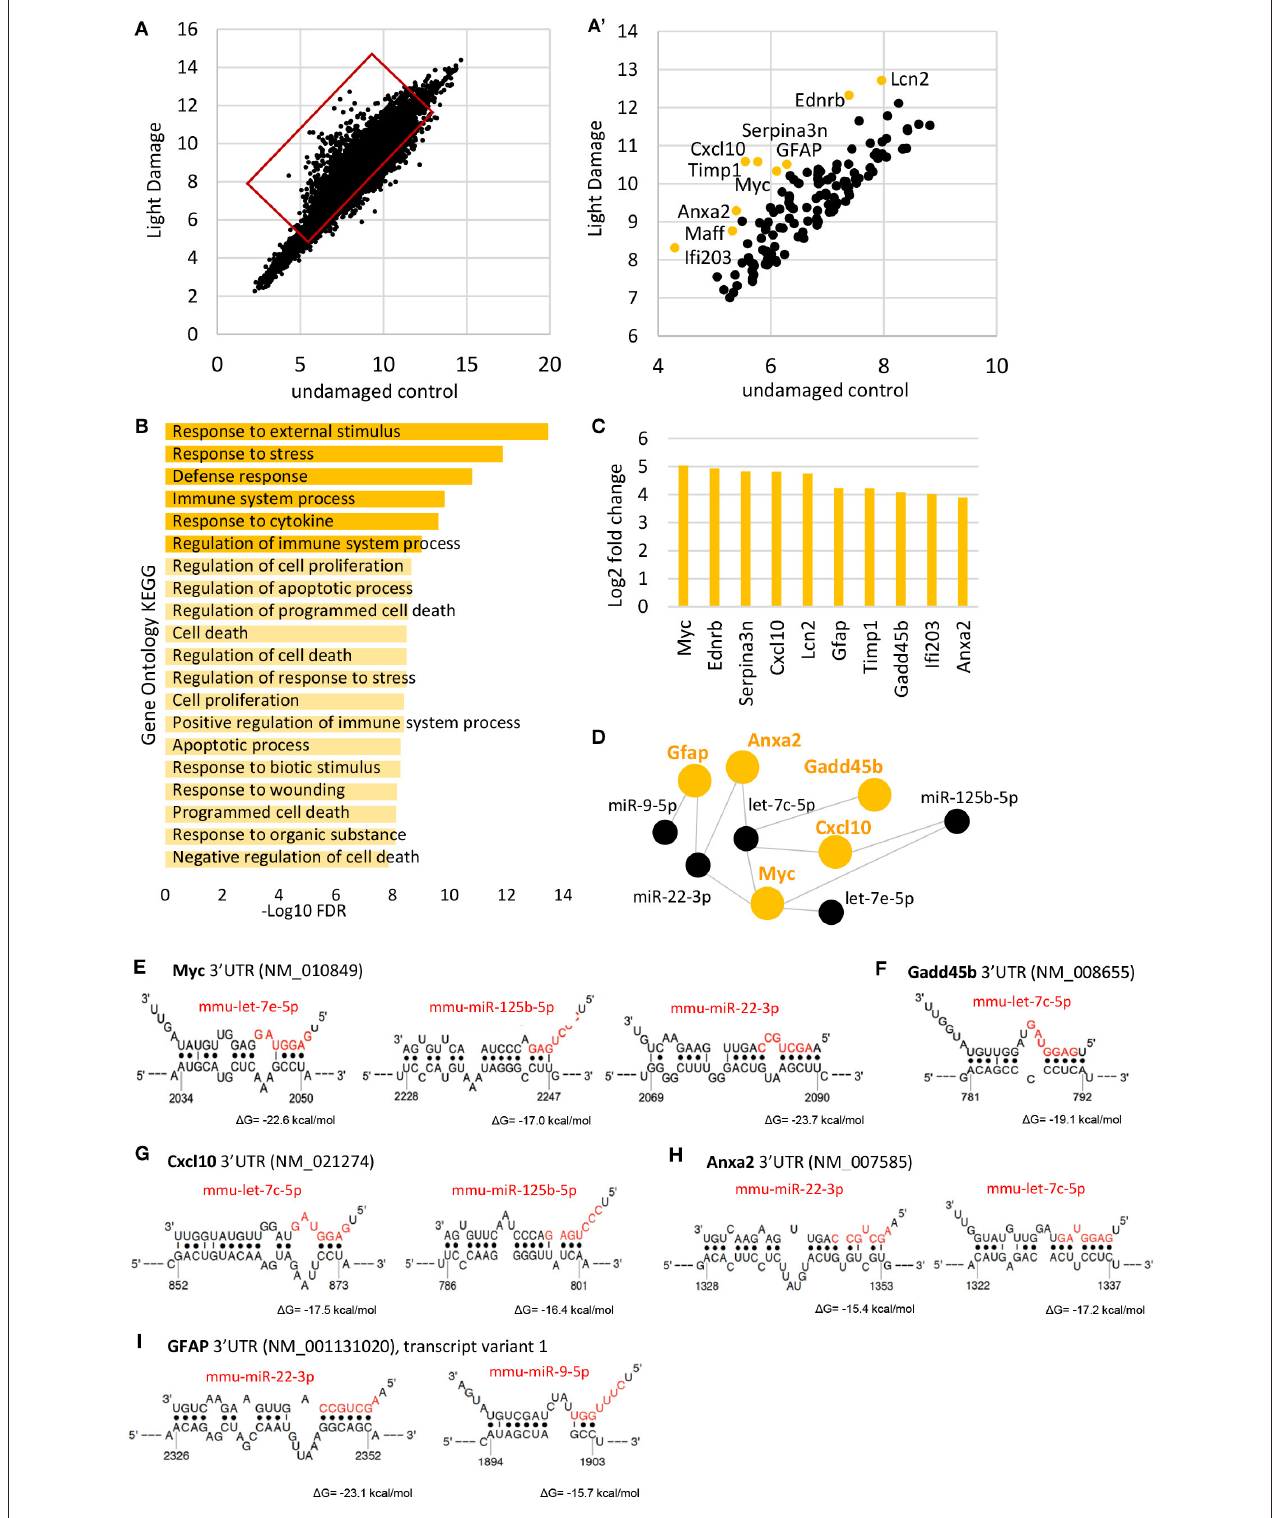
FIGURE 4 | Müller glia gene expression after light damage. (A) Scatterplot of genes expressed in undamaged controls and 7 days after light damage (LD) from microarray (log 2 of relative expression). (A ′ ) Scatter plot of the top 100 highly expressed genes after light damage. (B) Gene ontology of the top 100 genes upregulated after light damage using ShinyGO v0.61. (C) Expression levels of the top 10 genes upregulated after light damage compared to undamaged controls